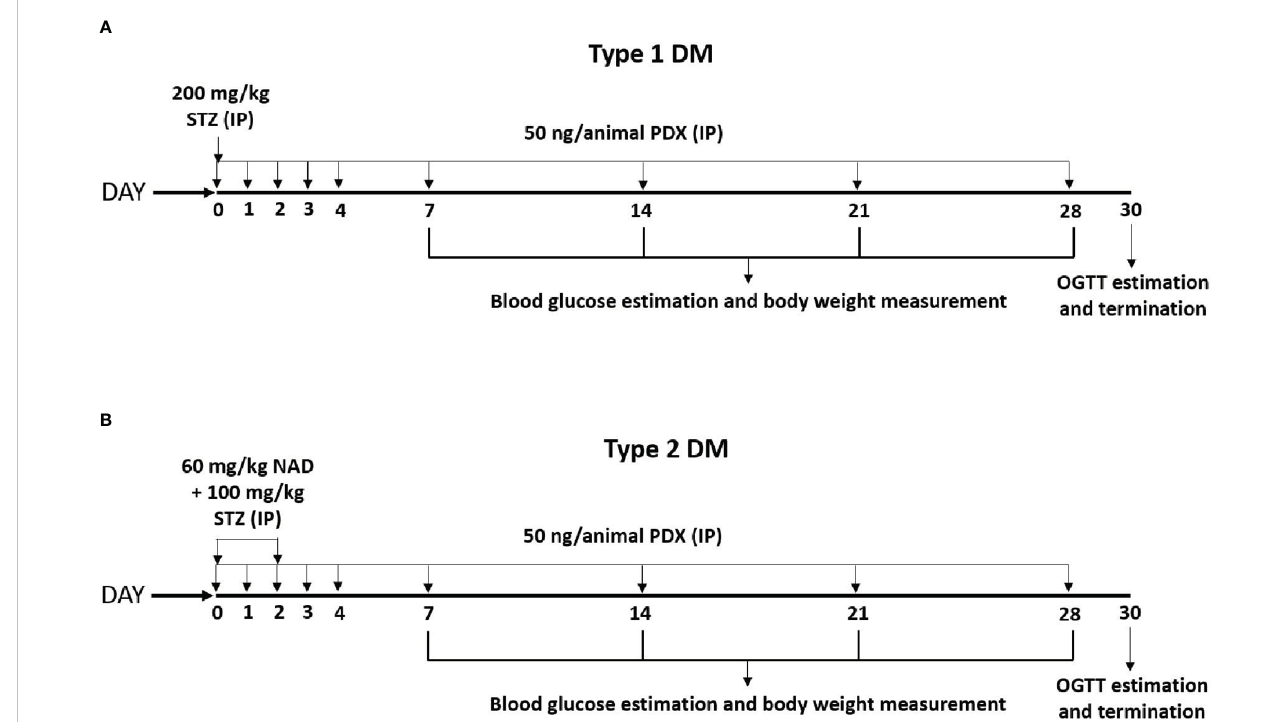
FIGURE 1 Experimental plan for STZ induced Type 1 and Type 2 diabetes mellitus (DM) in male Swiss albino mice. (A) Type 1 DM protocol – Diabetes was induced by a single dose of STZ (200 mg/kg body weight, IP) on day 0. These animals received PDX (50 ng/animal, i.p.) simultaneously along with STZ on day 0 and for the next 5 consecutive days (Day 0 to Day 4). The STZ + PDX group also received PDX every week for the next 4 weeks [as shown in the (A) ]. Experiment was terminated and animals were sacri fi ced on Day 30 following OGTT estimation. (B) Type 2 DM protocol – Diabetes was induced by the administration of STZ (100 mg/kg body weight, i.p.) on day 0 and day 2. NAD (60 mg/kg body weight) was injected 15 min prior to STZ administration on day 0. STZ + PDX animals received PDX (50 ng/animal i.p.) on day 0 and the following 4 consecutive days (Day 0 to Day 4). Subsequently STZ +PDX group received PDX (50 ng/animal i.p.) once every week for the next 4 weeks. Experiment was terminated and animals were sacri fi ced on Day 30 following OGTT estimation [see (B) ]. STZ, Streptozotocin; PDX, 10(S),17(S)-DiHDoHE; NAD, Nicotinamide; OGTT, Oral Glucose Tolerance Test; i.p.,